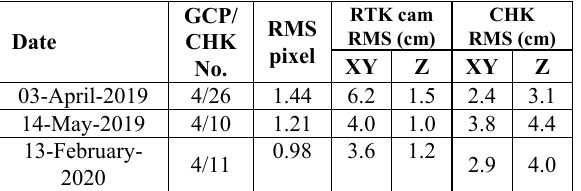
Table 2. Orientation errors.